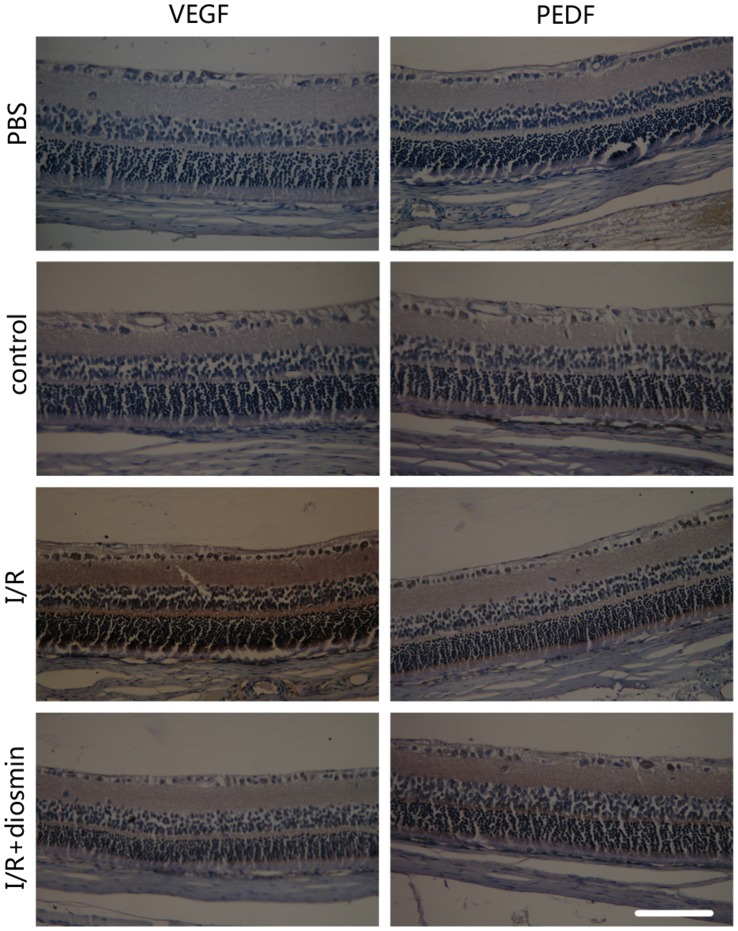
The Immunoreactivity for VEGF and PEDF in retina.No significant immunoreactivity for VEGF and PEDF was found in control retina. I/R injury induced a stronger immunoreactivity for VEGF in retina and diosmin administration relieved this trend. The PEDF immunoreactivity was nearly similar to the control group after 24 h retinal ischemia, while diosmin administration immensely increased this immunoreactivity. Scale bar, 100 µm.